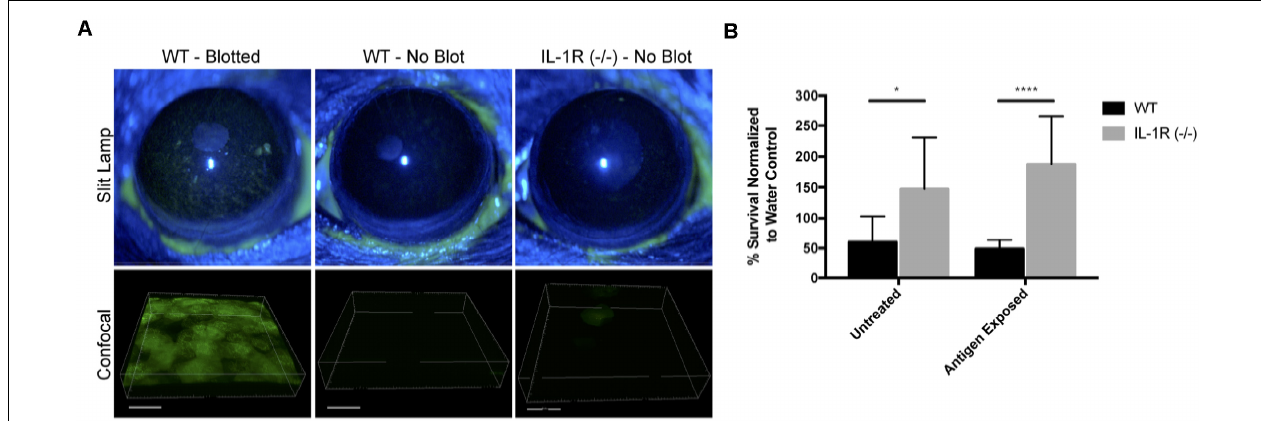
FIGURE 8 | Uninjured IL-1R (–/–) murine corneas do not exhibit fluorescein staining, but show reduced antimicrobial activity. (A) After tissue paper blotting, wild-type (WT) corneas were susceptible to fluorescein staining suggesting the disruption of epithelial integrity. Non-blotted (uninjured) WT and IL-1R (–/–) corneas showed little or no fluorescein staining. (B) IL-1R (–/–) corneal epithelial lysates showed reduced antimicrobial activity against P. aeruginosa strain PAO1 compared to WT lysates. A similar result was obtained in a separate set of experiments in which corneas were exposed to bacterial antigens prior to lysate production. ∗ P < 0.05, ∗∗∗∗ P < 0.0001 (Students t-